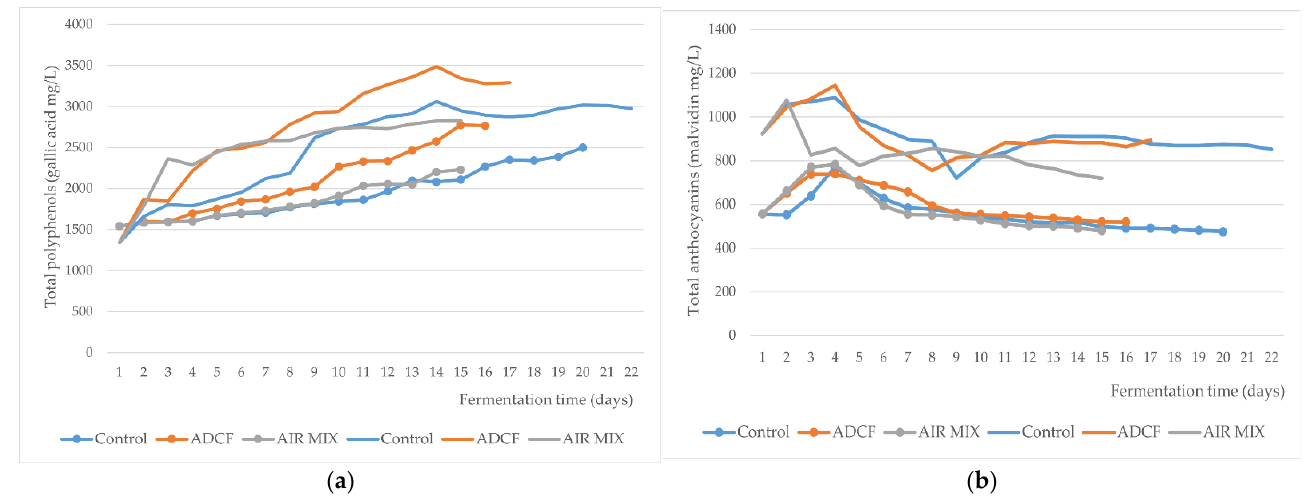
Figure 2. ( a ) Behaviors of total polyphenols extraction in 208 hL tank, 2020 and 2021 years; ( b ) be- haviors of total anthocyanins extraction in 208 hL tank, 2020 and 2021 years; 2020 (line with solid dots).